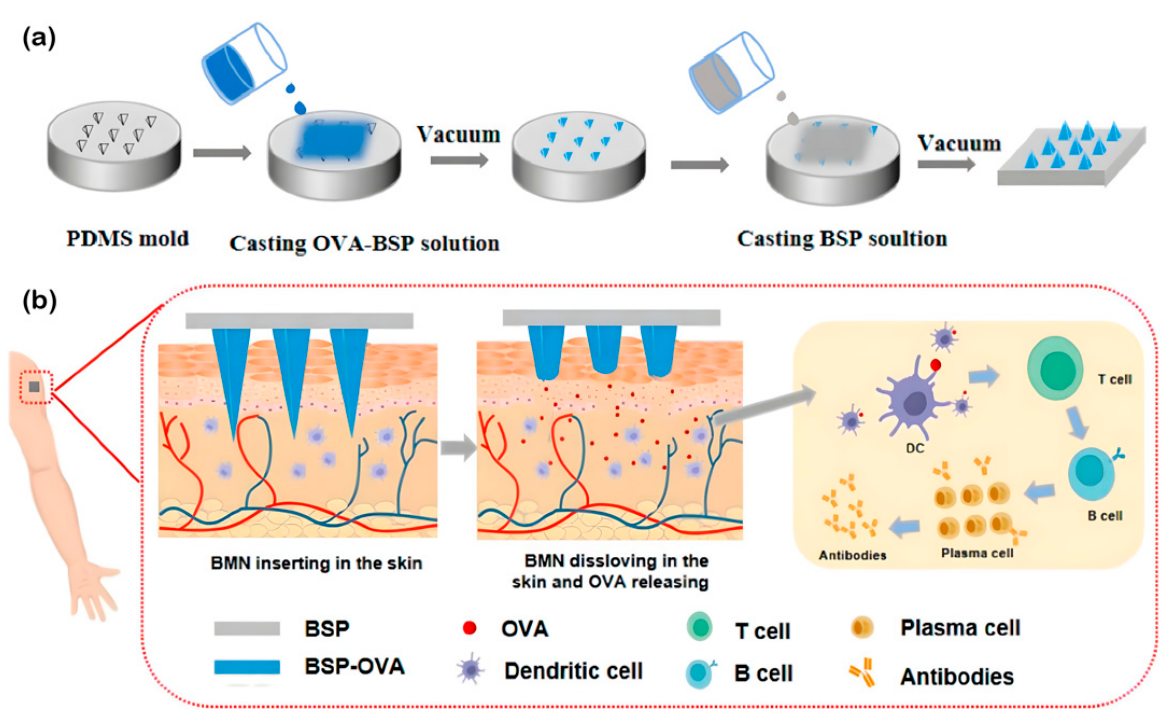
Figure 4. Schematic diagram of the preparation process and ovalbumin (OVA) delivery condition. ( a ) Two-step preparation of Bletilla striata polysaccharide (BSP) microneedle (MN) (BMN). ( b ) Trans- dermal drug delivery of the OVA-loaded BMN system and the release of the drug can be triggered by the dissolving of BSP in the skin interstitial fluid [97]. Reproduced with permission from Ping Zhou, International Journal of Biological Macromolecules; published by Elsevier, 2022. Table 1. Some latest polysaccharide-based MNs.